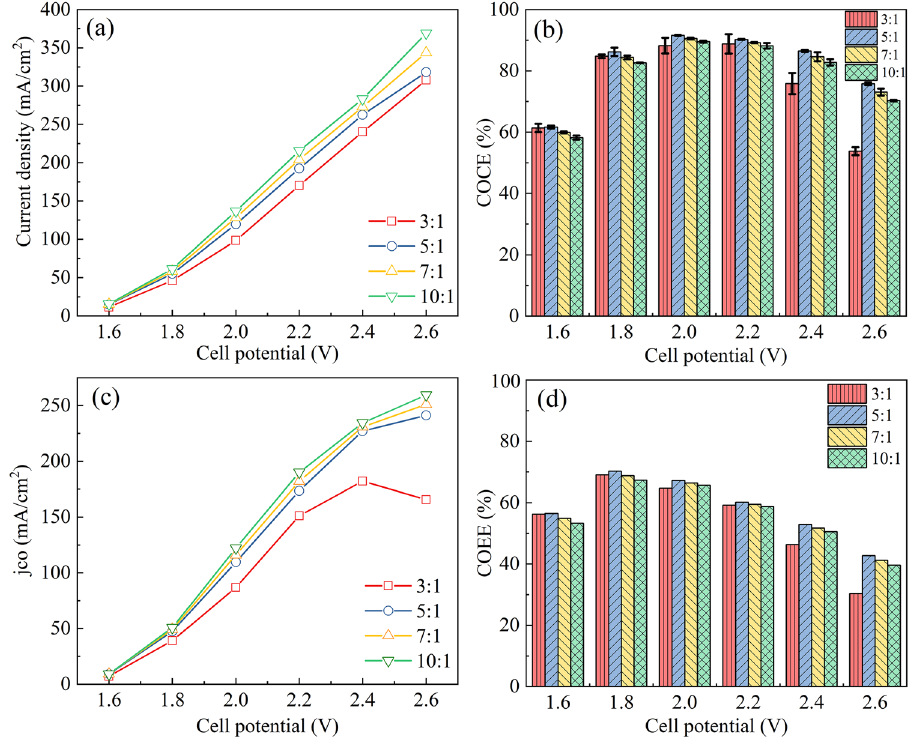
Figure 5. Cell performance of the electrodes with different Nafion contents. (a) j total and (c) j CO , (b) COCE and (d) COEE, as a function of the cell potential.